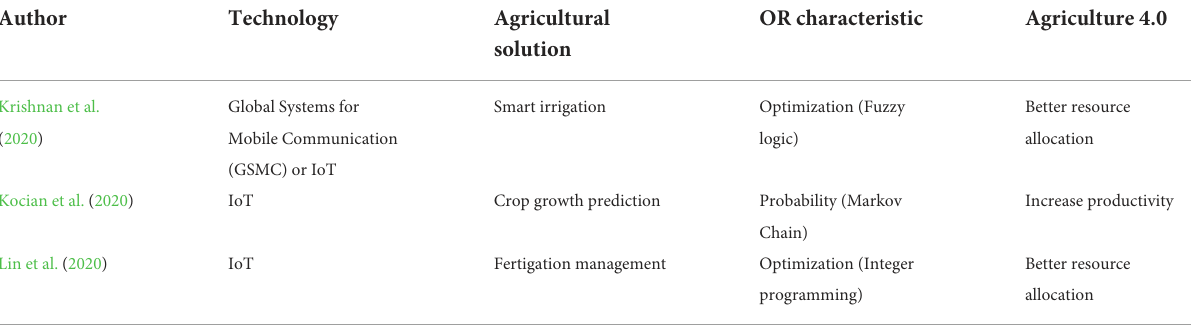
TABLE 8 Research stream: precise agriculture management using IoT.